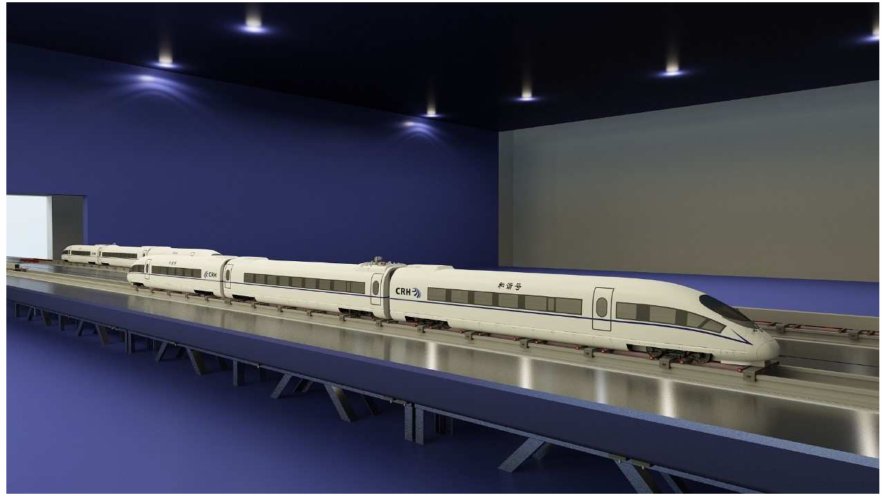
Figure 2. Moving model experimental set-up in